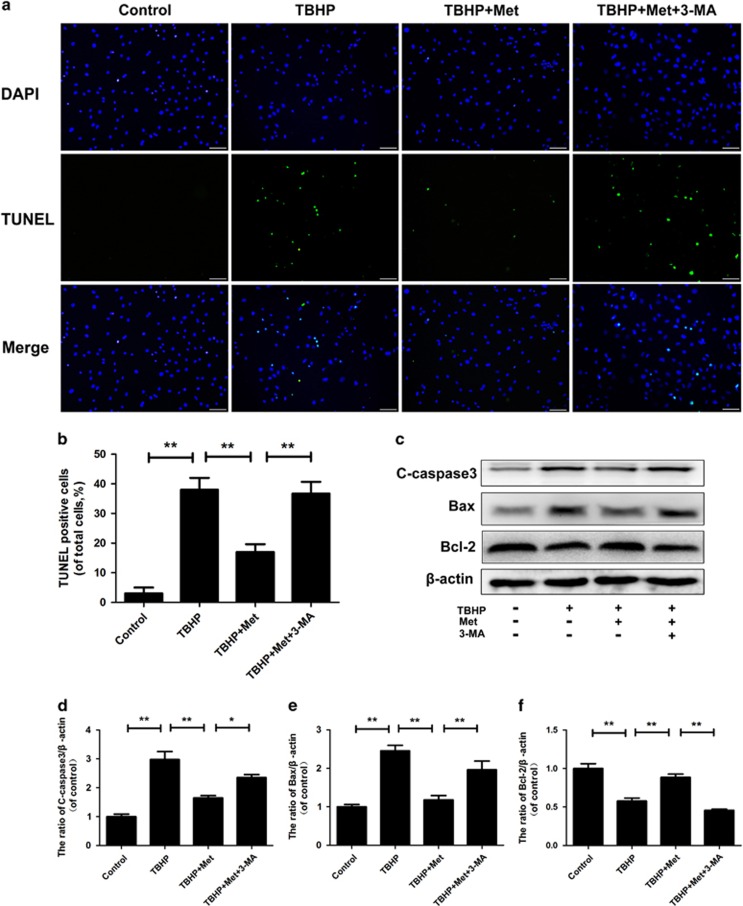
Metformin treatment reduces nucleus pulposus cell apoptosis under oxidative stress. (a–b) TUNEL assay was performed in nucleus pulposus cells as treated above (original magnification × 200, scale bar: 50 μm). (c–f)The protein expression of cleaved-caspase3, Bax and Bcl-2 in nucleus pulposus cells treated as above. The data in the figures represent the averages±S.D. Significant differences between the treatment and control groups are indicated as **P<0.01, *P<0.05, n=3